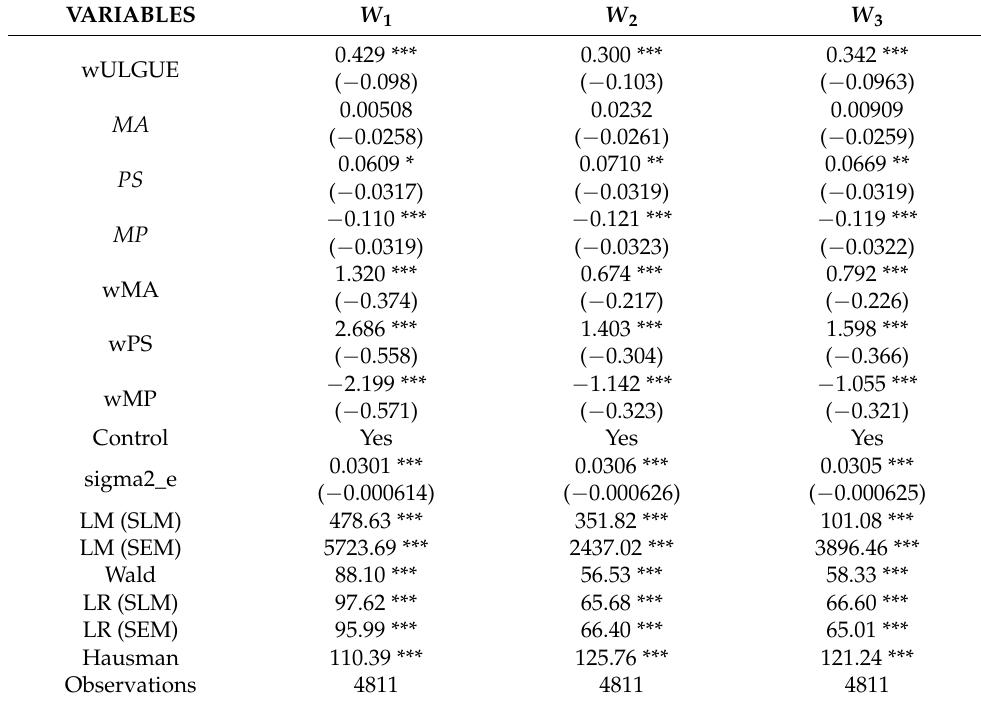
Table 5. Parameter estimation results of the spatial Durbin